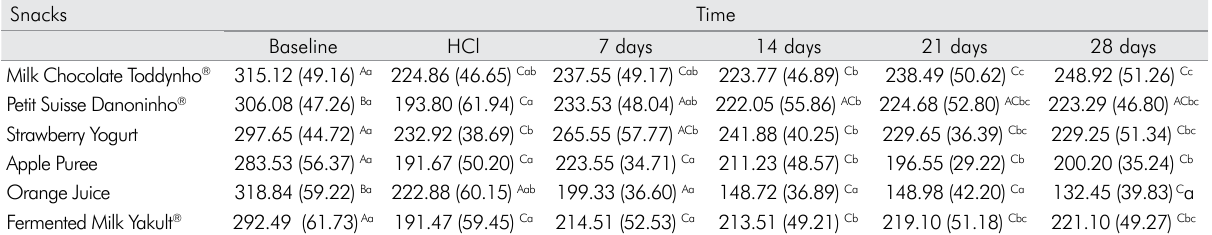
Table 2. Mean values and standard deviations of Knoop microhardness at different times of exposure to snacks.